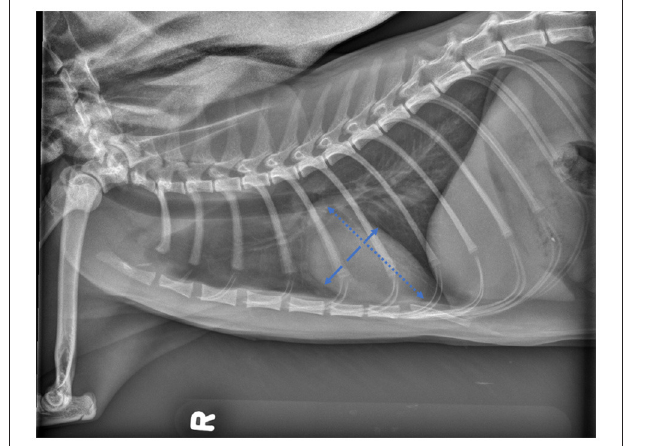
TABLE 2 | Summary table of the Bland–Altman